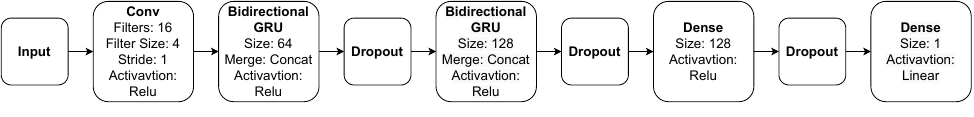
Figure 3. Architecture of WGRU.